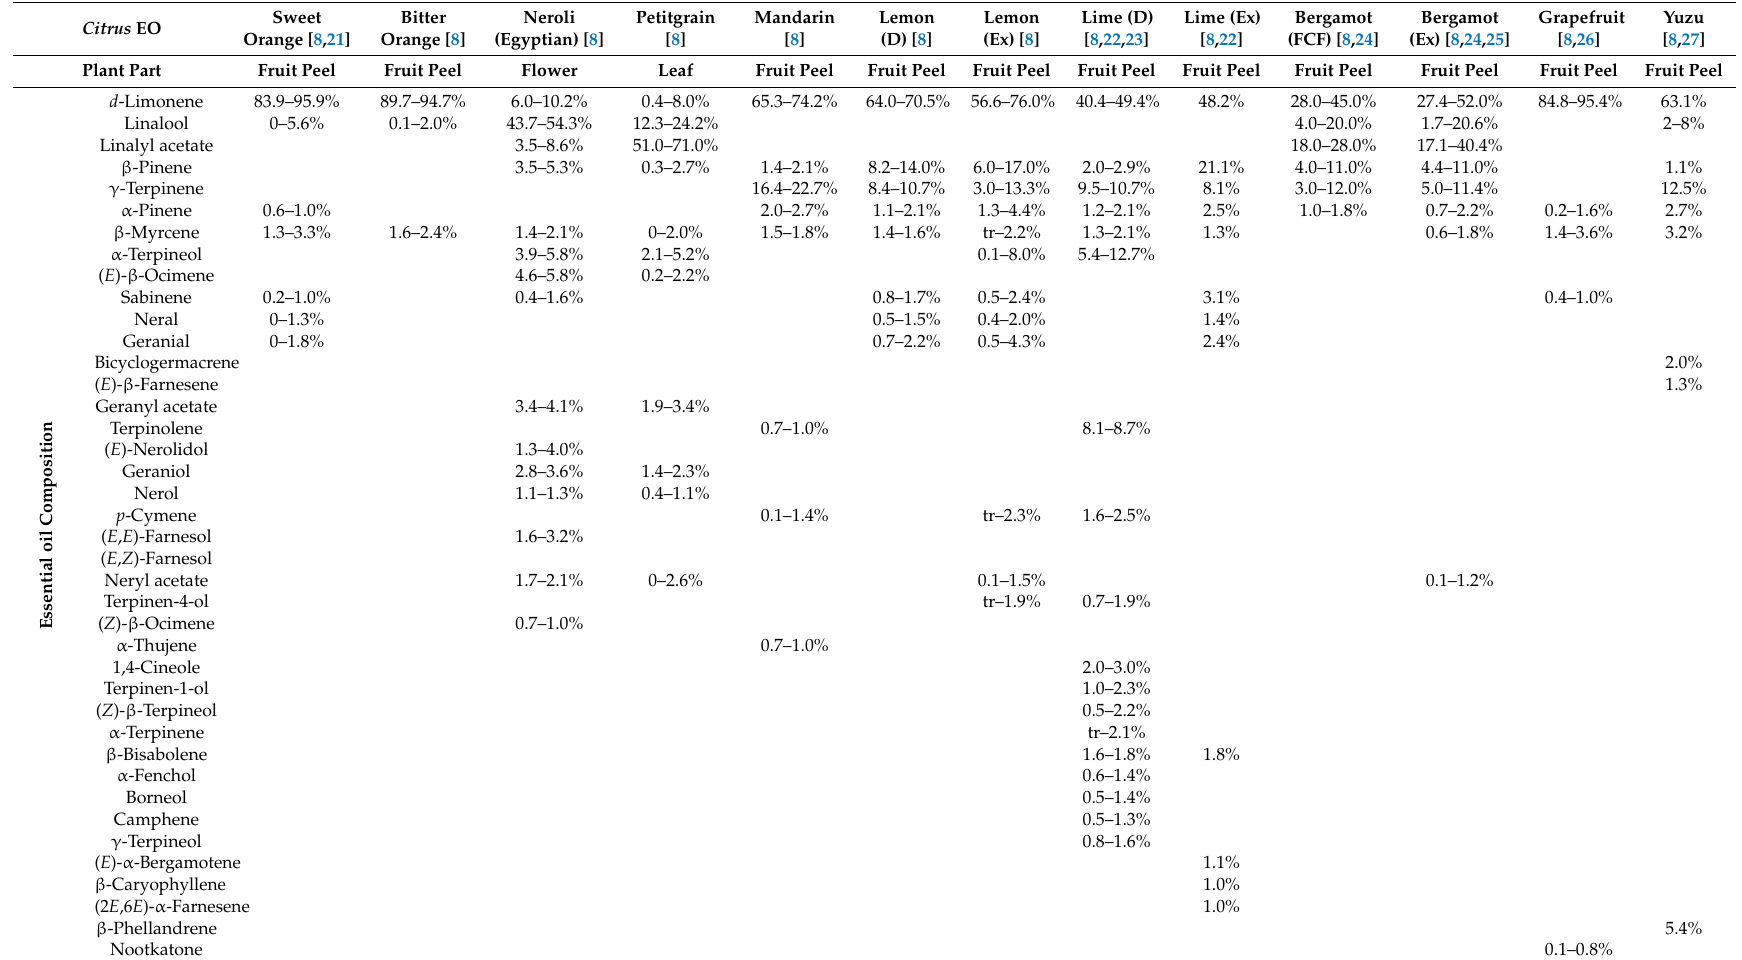
Table 1. Major volatile components in essential oils of different Citrus